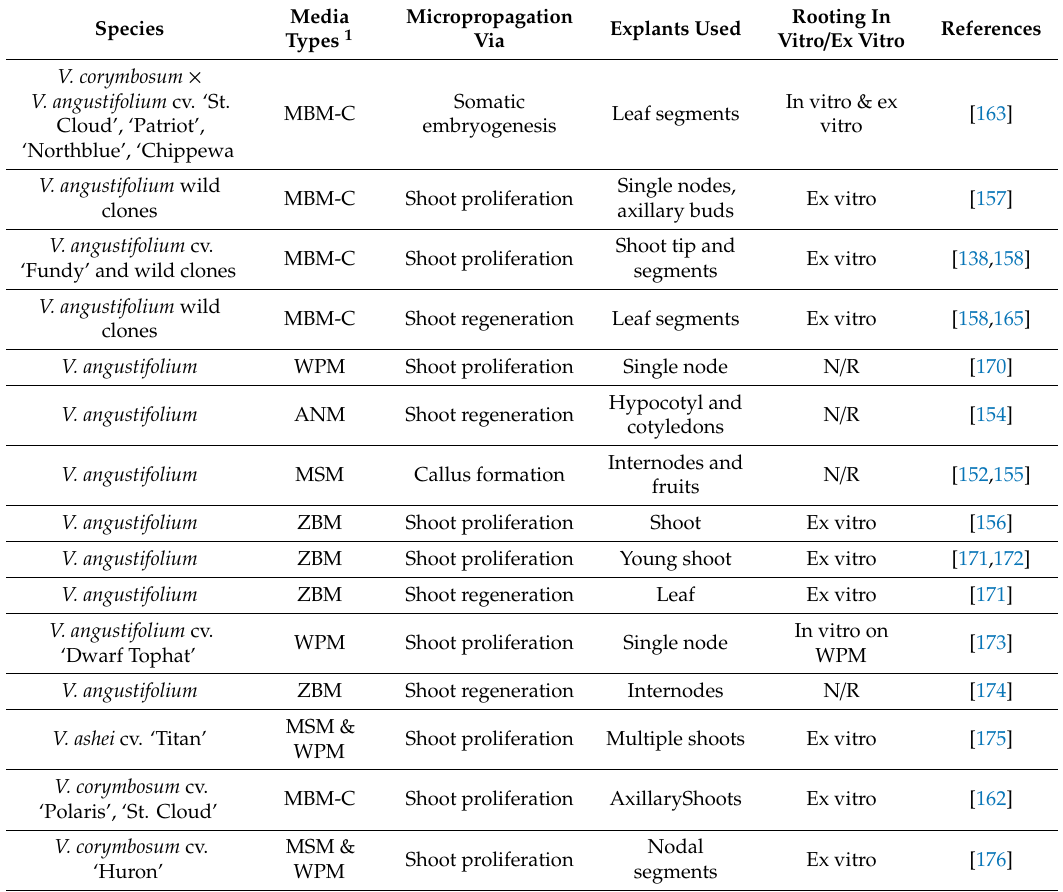
Table 3. Examples of in vitro propagation of Vaccinium species using di ff erent basal media and explants.